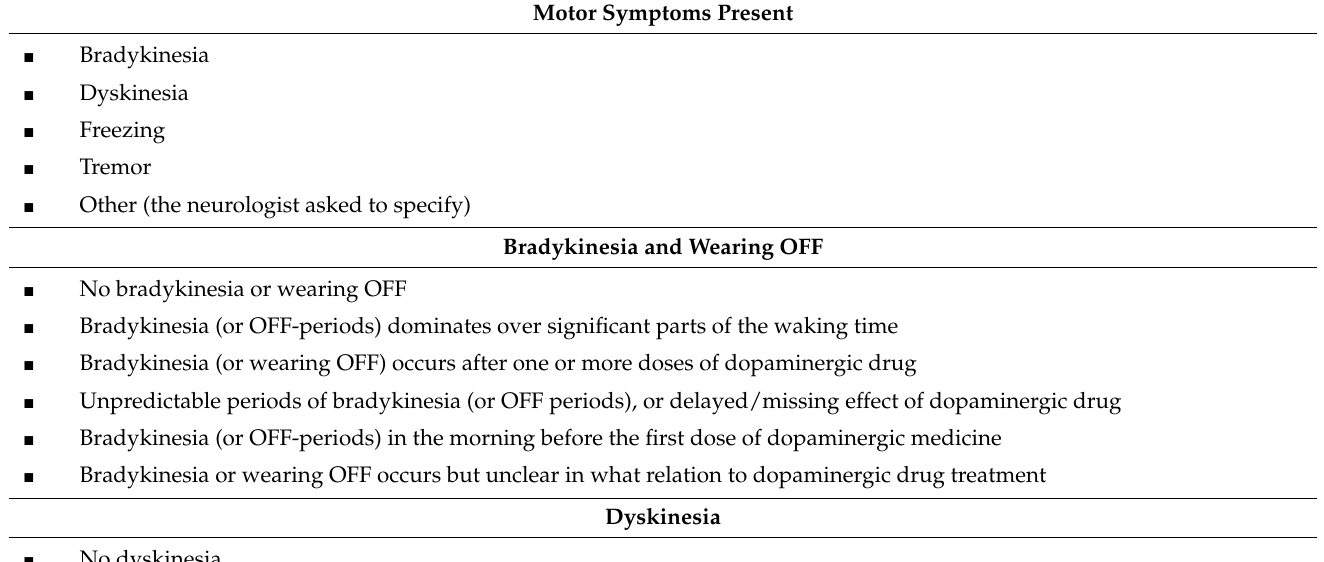
Table 1. Pre-defined set of options for describing the participant’s clinical state. The treating neurologist chose one or several options for each item (except for ICD and Compliance, where only one answer could be chosen). The set of options was given twice, first based on the clinical assessment, and again based on the PKG